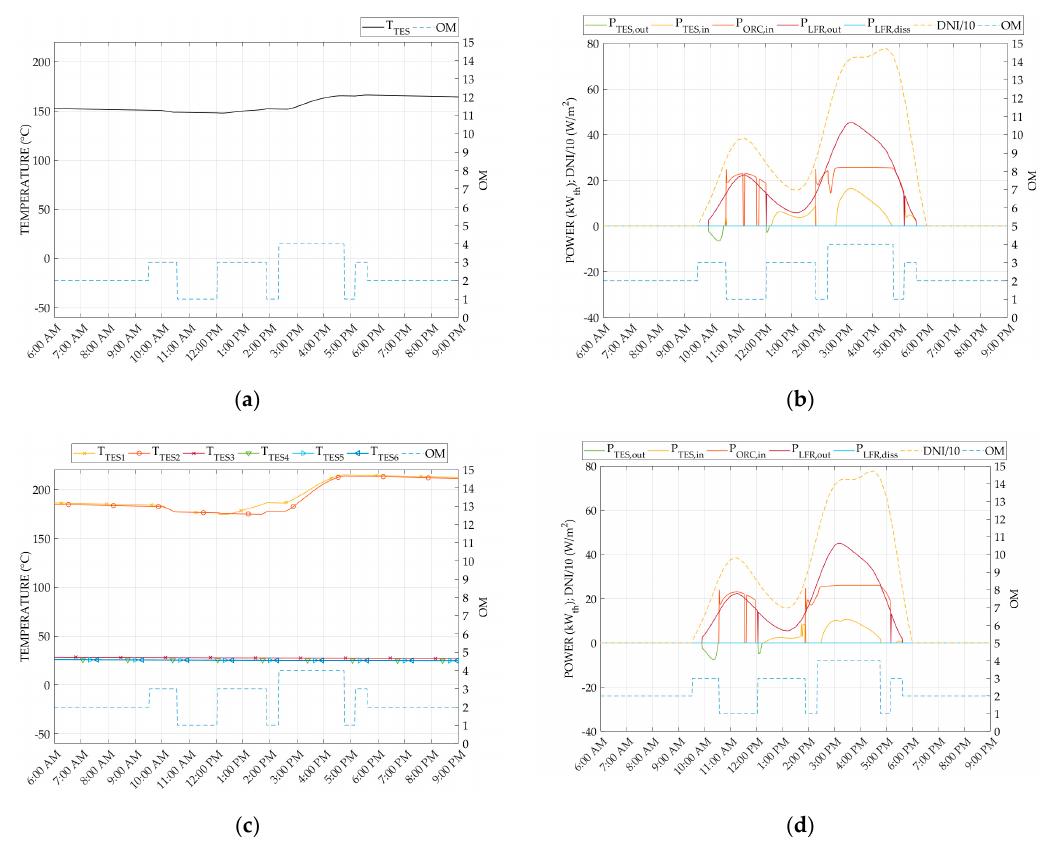
Figure 9. Daily temperatures ( a ) and power trends ( b ) of the LHTES compared with the daily temperature ( c ) and power trends ( d ) of the sub-LHTES for a typical winter day (30 January). The graphs represent also the operating mode (OM) of the plant, as specified in Table 1.